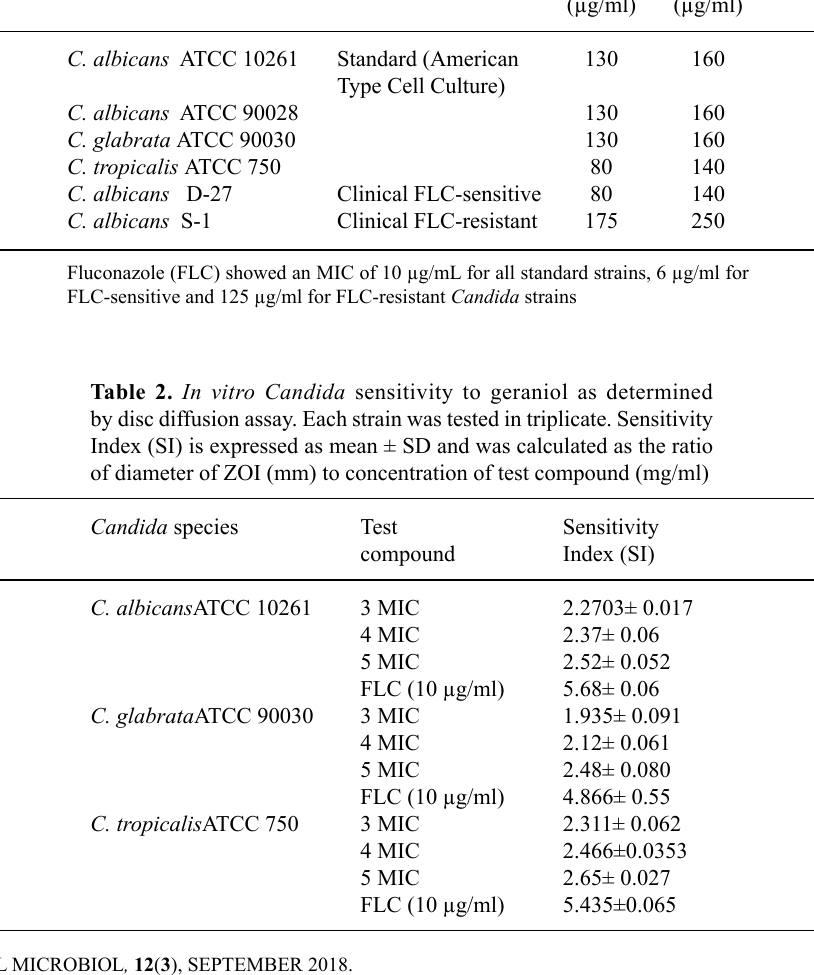
table 1. Minimum inhibitory and fungicidal concentrations for geraniol against Candida strains Candida strains Type MIC MFC (µg/ml) (µg/ml) C. albicans ATCC 10261 Standard (American 130 160 Type Cell Culture) C. albicans ATCC 90028 130 160